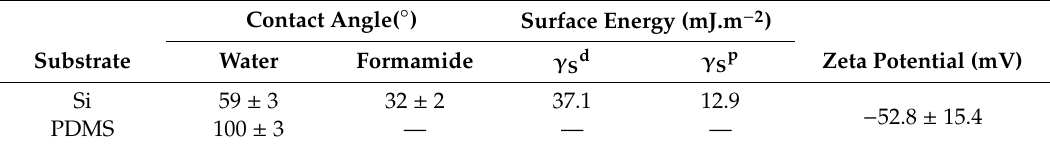
Table 3. Static contact angles, surface energy, and zeta potential of N1 deposited thin